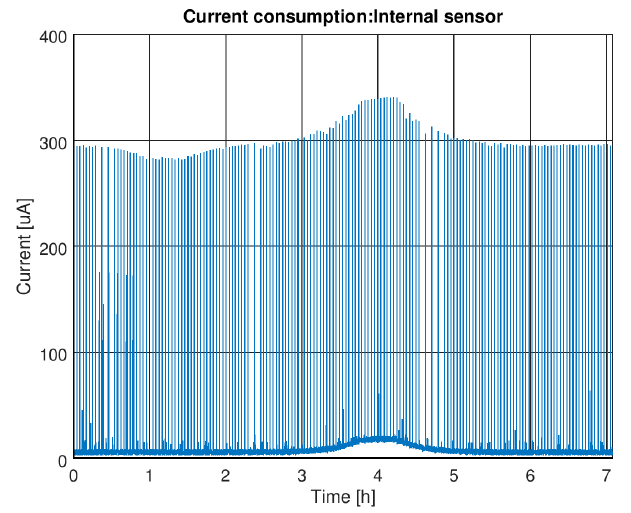
Figure 4. Current consumption of the SL900A sensor tag.